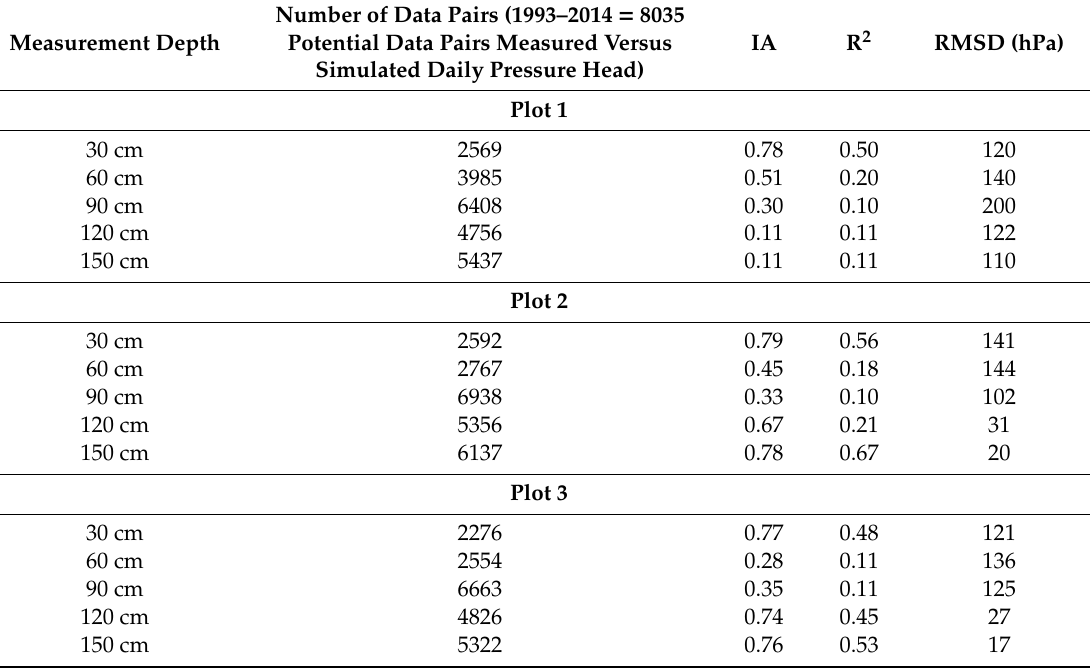
Table 5. Modelling performance for pressure